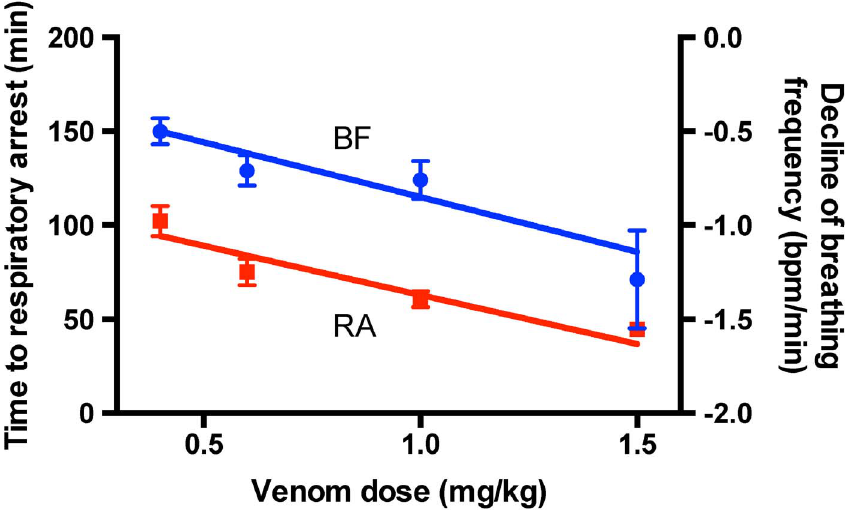
Figure 4. Summary plots of the mean times to respiratory arrest and mean venom-induced decline of respiration frequency for a range of Ptx venom doses. Both measures exhibited an approximately linear relationship with venom dose for the range shown (n=6, 6, 11 & 3 for 0.4, 0.6, 1.0 & 1.5 mg/kg respectively).